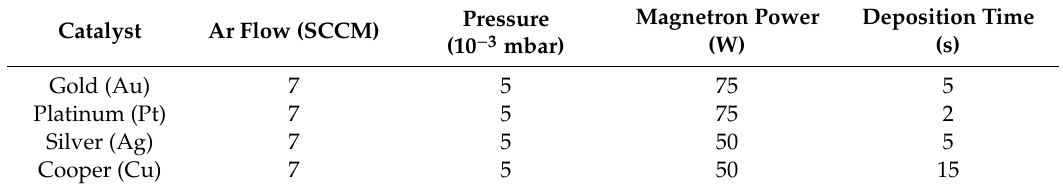
Table 1. Experimental parameters used in magnetron sputtering system for catalyst seed deposition. Catalyst Ar Flow